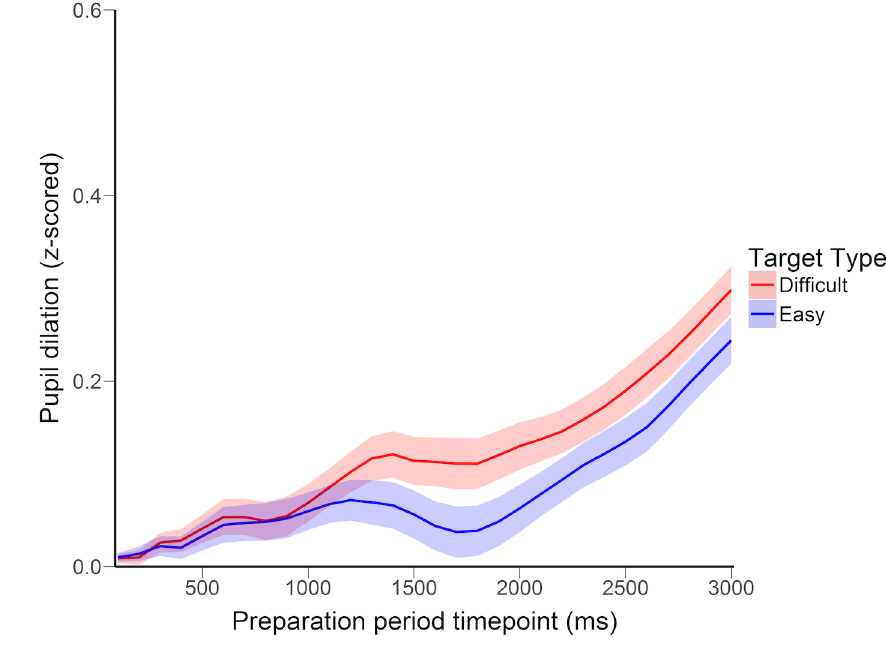
Fig 7. Pupil dilation across the preparation period in Experiment 3. Error bandsdepict standarderror of the mean color vs shape difference scores.